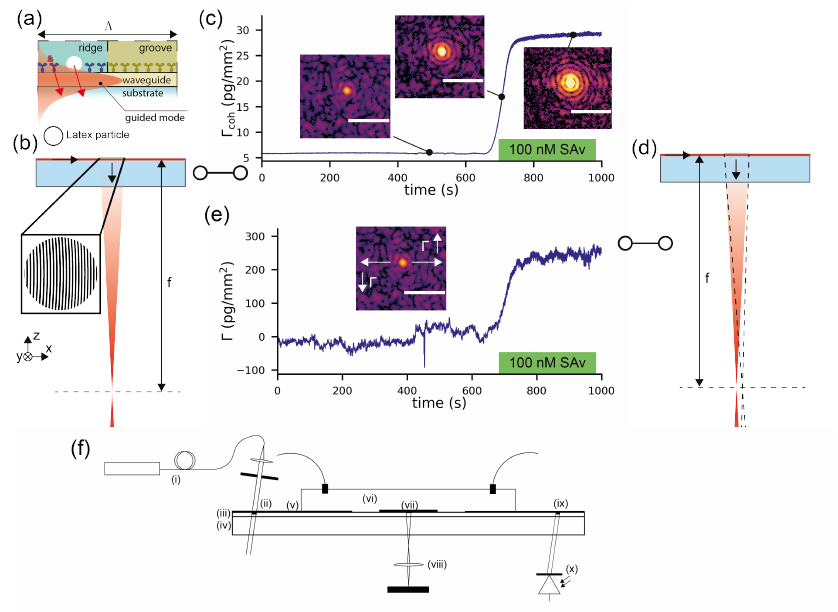
Figure 1. Concept of a waveguide-based combined refractometric and diffractometric biosensor for demonstration of the robustness of spatially locked-in diffractometric biosensors: ( a ) the sensor constitutes a diffraction grating on top of a high refractive index Ta 2 O 5 slabwaveguide. The diffraction grating consists of roughly 1000 ridges and grooves with grating period Λ . One grating period is enlarged. A small bias (mass excess) on the ridges is introduced by chemically linked polystyrene particles (Latex) that yield a detectable diffraction signal. An antibody or similar capture molecule (in this case, just biotin) is immobilized on the ridges that bind the target molecule. The light diffracted by the target molecule interferes constructively with the light diffracted by the polystyrene particles. The grooves were functionalized by a molecule that is chemically similar to the capture molecule on the ridges but does not bind the target molecule (in this case, a short polyethylene glycol) [26,46]. ( b ) The diffraction grating has the form of a diffractive lens that focuses the diffracted light from the guided mode at a focal distance f . ( c ) Experimental diffractometric signal: as molecules bind (Streptavidin—SAv), the diffraction efficiency of the grating increases, which leads to a quadratic increase of the diffracted power with bound mass. From this, a binding curve can be generated. The diffractometric biosensor measures the refractive index difference, i.e., the coherent mass density Γ coh , between ridges and grooves. [27,31,50] (an image of the focal plane is shown in the insets; the scale bar is 30 µ m). ( d ) The binding of molecules, irrespective of whether they bind on the ridge or the groove, increases the average refractive index of the cover medium close to the waveguide surface. This causes a change in the effective refractive index of the guided mode and hence in the outcoupling angle of the diffracted light, which manifests as a shift of the focal spot in the focal plane in the mode propagation direction. A binding event to the grooves cannot be discriminated from one to the ridges. ( e ) Experimental refractometric signal: from the shift of the molographic focal spot, a binding curve can be generated. The refractometric sensor measures the integrated refractive index change in the entire sensing volume, i.e., the total surface mass density Γ . ( f ) Schematic of the readout system: (i) a fiber coupled laser is expanded and hits a coupling grating (ii), sitting on the surface of the (iii) waveguide attached to a transparent substrate (iv). The grating is protected by an SiO 2 cover (v). (vi) Fluidics with connectors to execute real-time measurements. (vii) An array of molograms and (viii) the optical system observe them. An outcoupling grating (ix) in combination with a photodiode (x) quantifies the incident